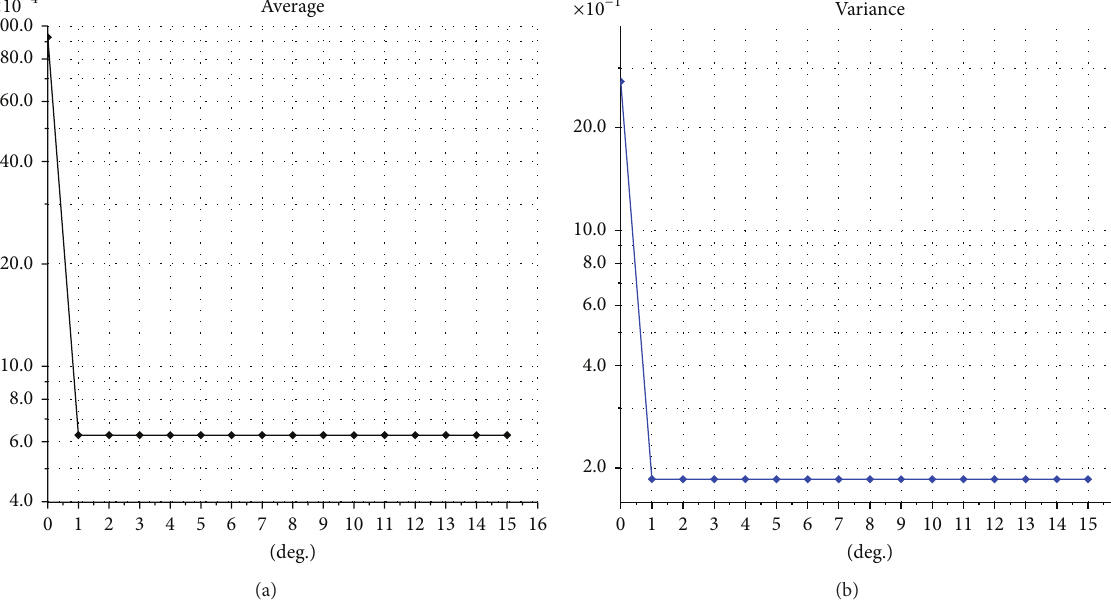
Figure 15: Semilogy scale plot of the absolute error of mean and variance computed via PCE of the CIR interest rate model at time 𝑇 = 1 with higher precision at computing {𝑅 𝑇 ,𝑗} 𝑁 𝑗=1 . Moreover, the parameters 𝛼 = 0.1 , 𝛽 = 0.2 , 𝜎 = 0.15 , and 𝑅 0 = 110 .